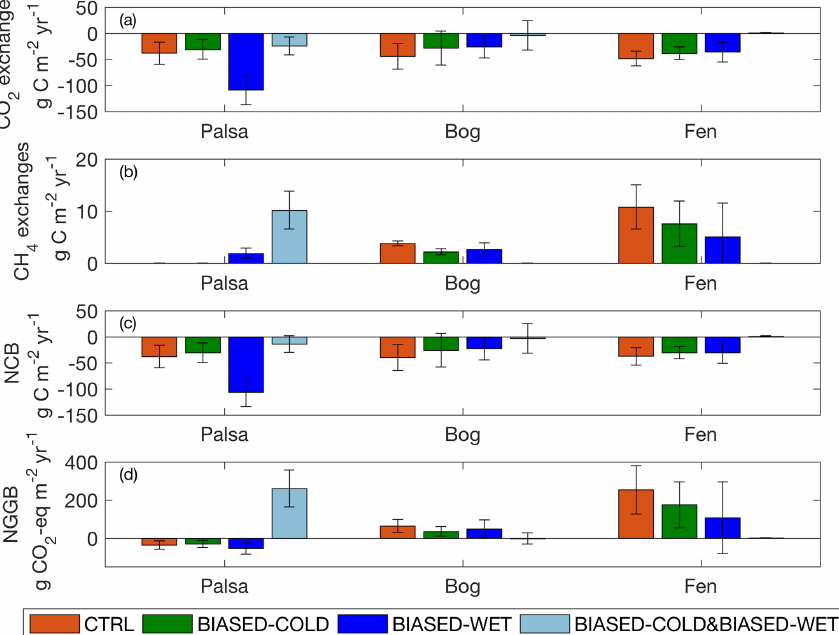
Figure 9. Annual CO 2 exchanges (a) , CH 4 exchanges (b) , net carbon balance (c) , and net greenhouse gas balance (d) simulated in the palsa, bog, and fen, under each set of simulations. Bars and error bars are the means and standard deviations calculated from 2003 to 2007, respectively. Positive and negative values indicate effluxes from and influxes to the site,